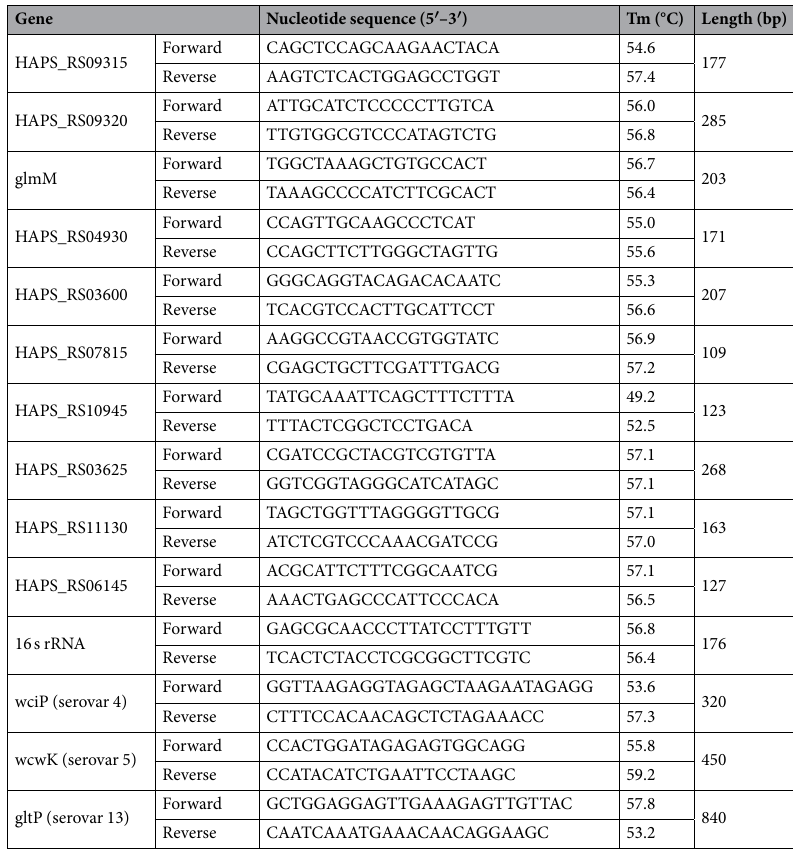
Table 1. Primers of RT-qPCR and